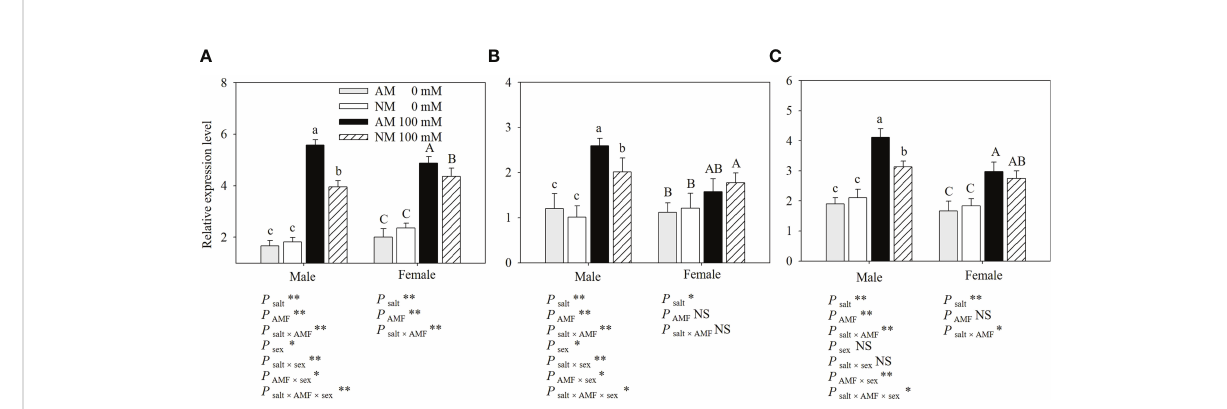
FIGURE 5 Effects of AMF inoculation on relative expression level of PeSOS1 (A) , PeHKT1 (B) and PeNHX1 (C) of P. euphratica males and females under different salt conditions AM, AMF inoculation; NM, non-inoculation; 0 mM, without salt stress; 100 mM, under salt stress; AMF, AMF formation; **: signi fi cant effect at P ≤ 0.01; *: signi fi cant effect at 0.01 < P ≤ 0.05; NS: no signi fi cant effect. Different letters (lowercases for males and capital letters for females) indicate signi fi cant difference at P ≤ 0.05, the data are means ± SD (n =